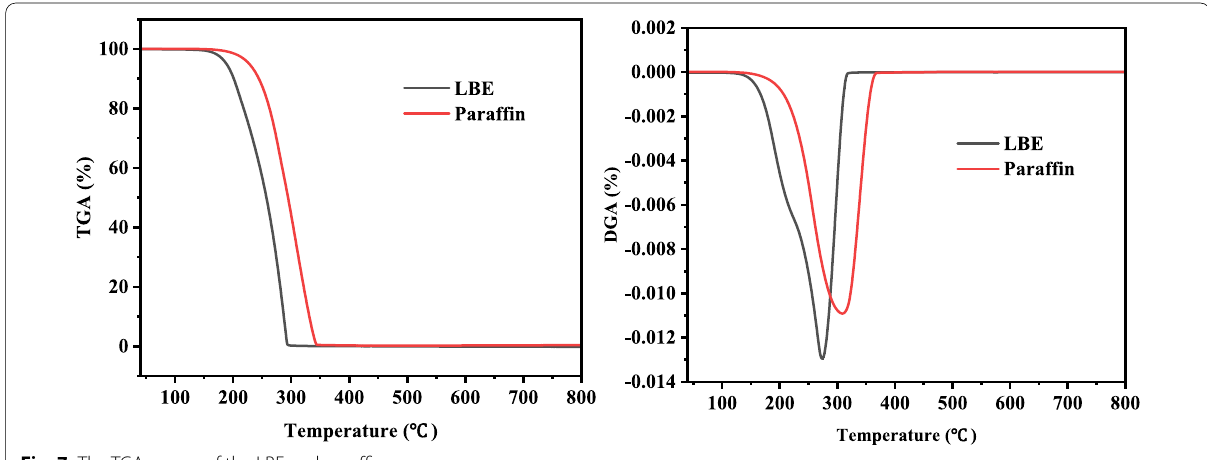
Fig. 7 The TGA curves of the LBE and